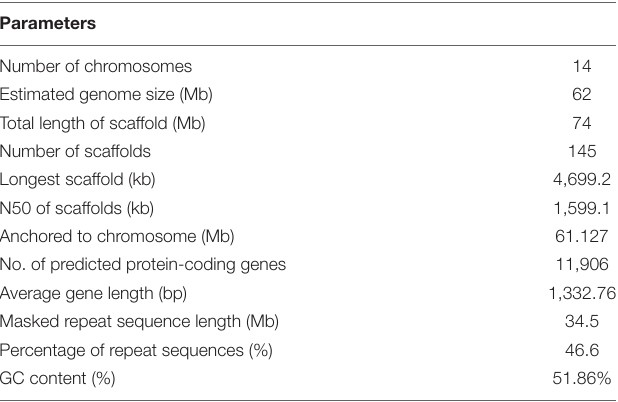
TABLE 1 | The features of the Wolfiporia cocos